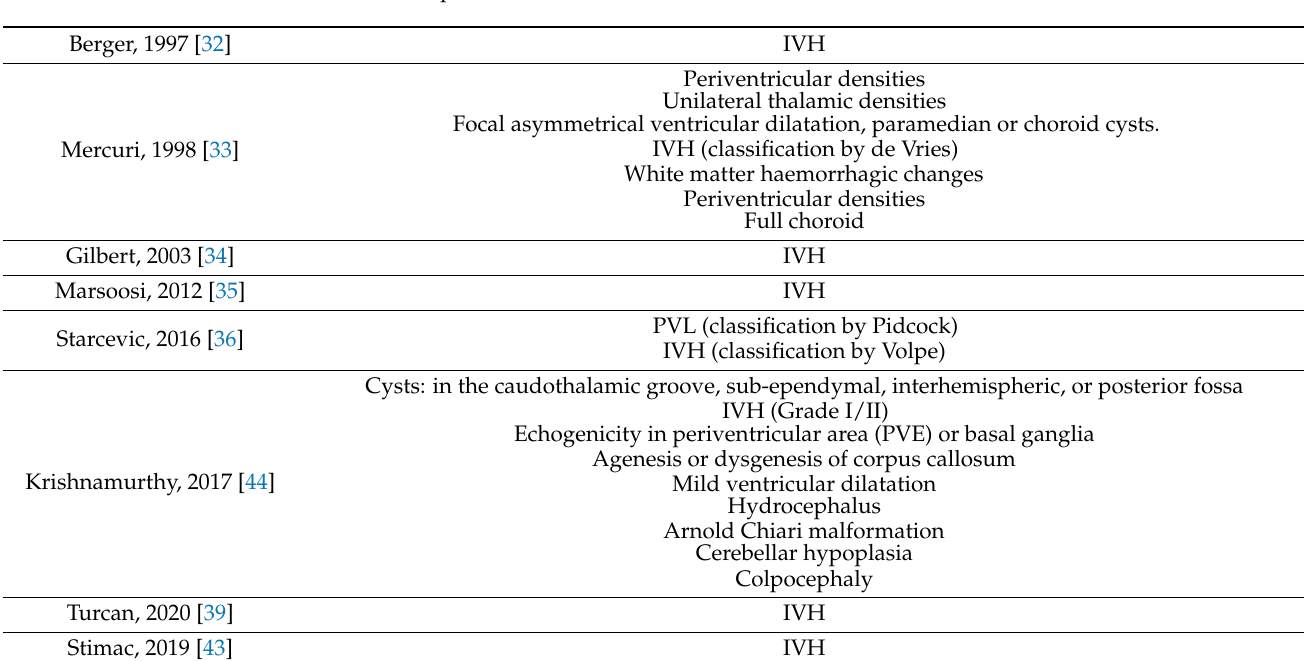
Table 8. Reported Abnormalities in LPT/Term FGR